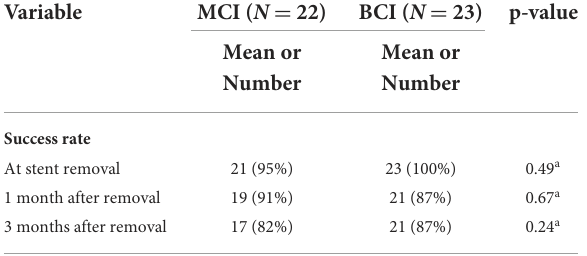
TABLE 2 Surgical outcomes of endoscopic DCR with MCI and BCI.